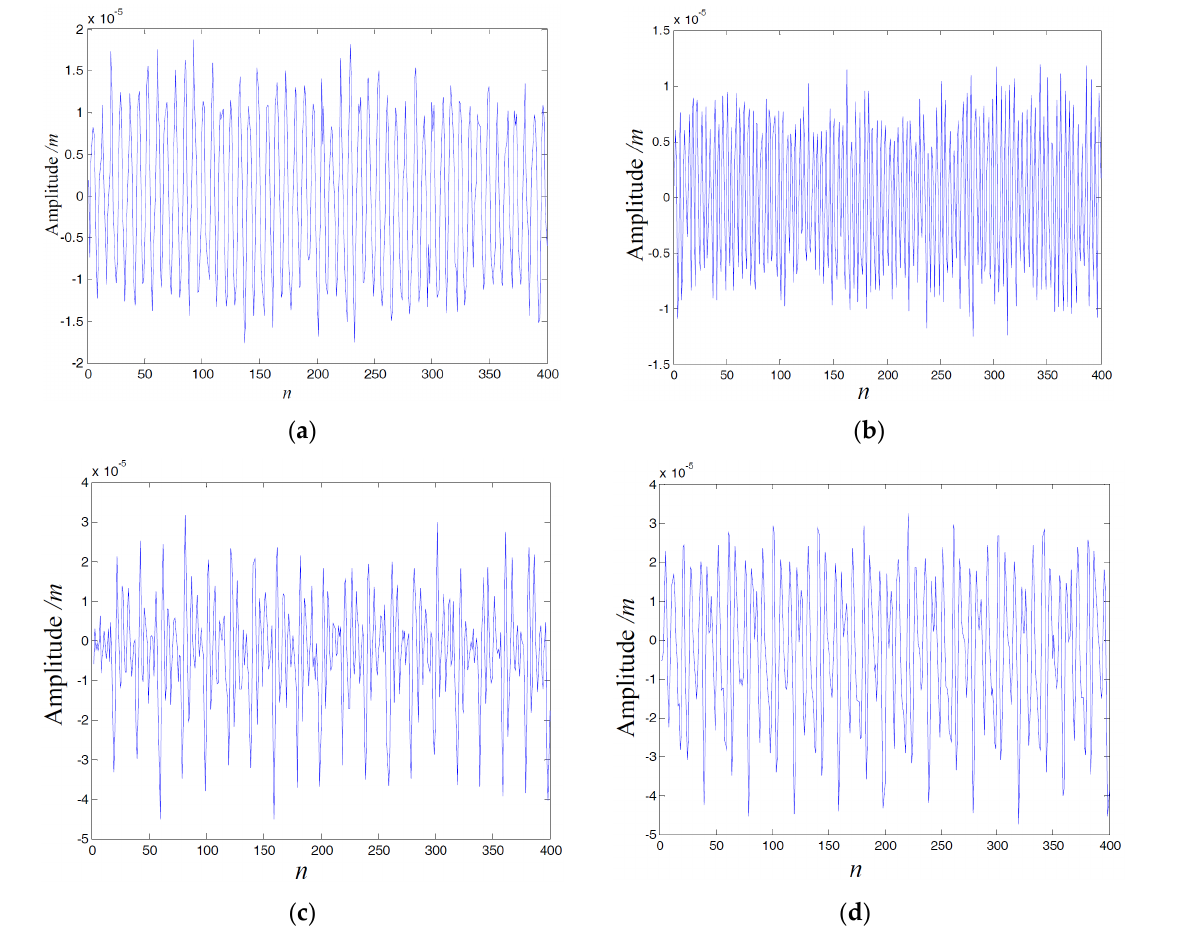
Figure 8. Simulation signals after adding noises (SNR = 87). ( a ) Unbalance; ( b ) misalignment; ( c ) rub ‐ impact; ( d ) the combination of rub ‐ impact and unbalance. Table 3. Fault recognition results with simulation.